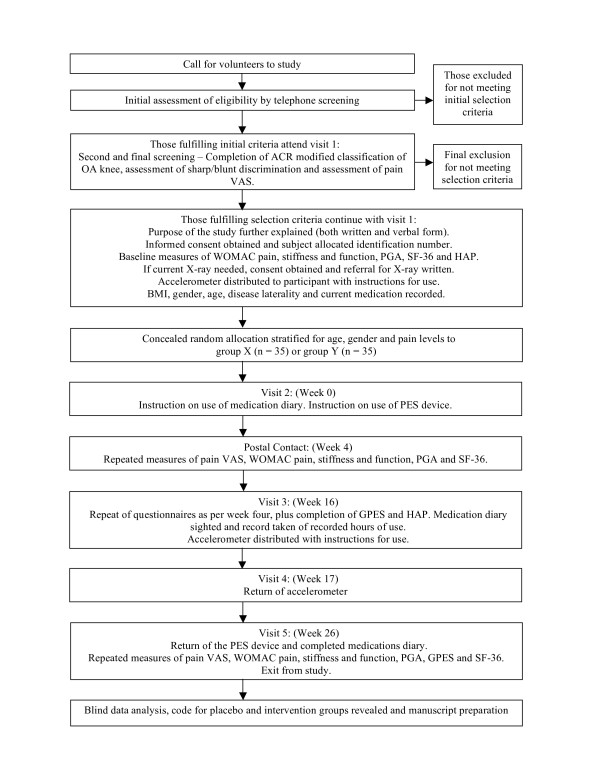
Summary of study procedure. ACR – American College of Rheumatology; WOMAC – Western Ontario and McMaster Universities Osteoarthritis Index; PGA – Patient Global Assessment; SF-36 – Medical Outcomes Study 36-item Short-Form Survey; HAP – Human Activity Profile; GPES – Global Perceived Effectiveness Scale.